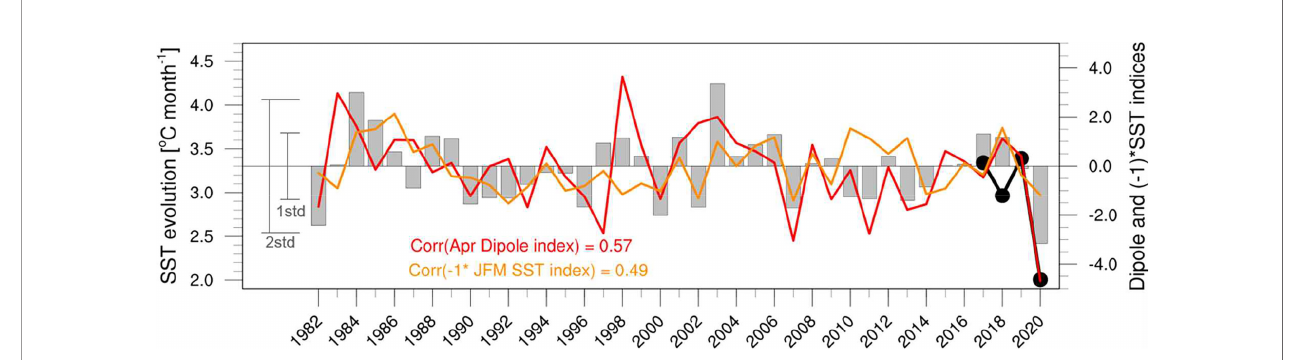
FIGURE 2 | Time series of the SST evolution between March and May from the S-ORS (solid black line with circle markers) and OISSTv2 (gray bars) averaged over the northeastern Yellow Sea [36.42° – 38.42°N, 123.74° – 125.74°E]. The solid red and orange lines indicate the dipole index and − 1xJM SST index, respectively. The one and two standard deviations for the climatological period 1982 – 2019 are shown in the plot.